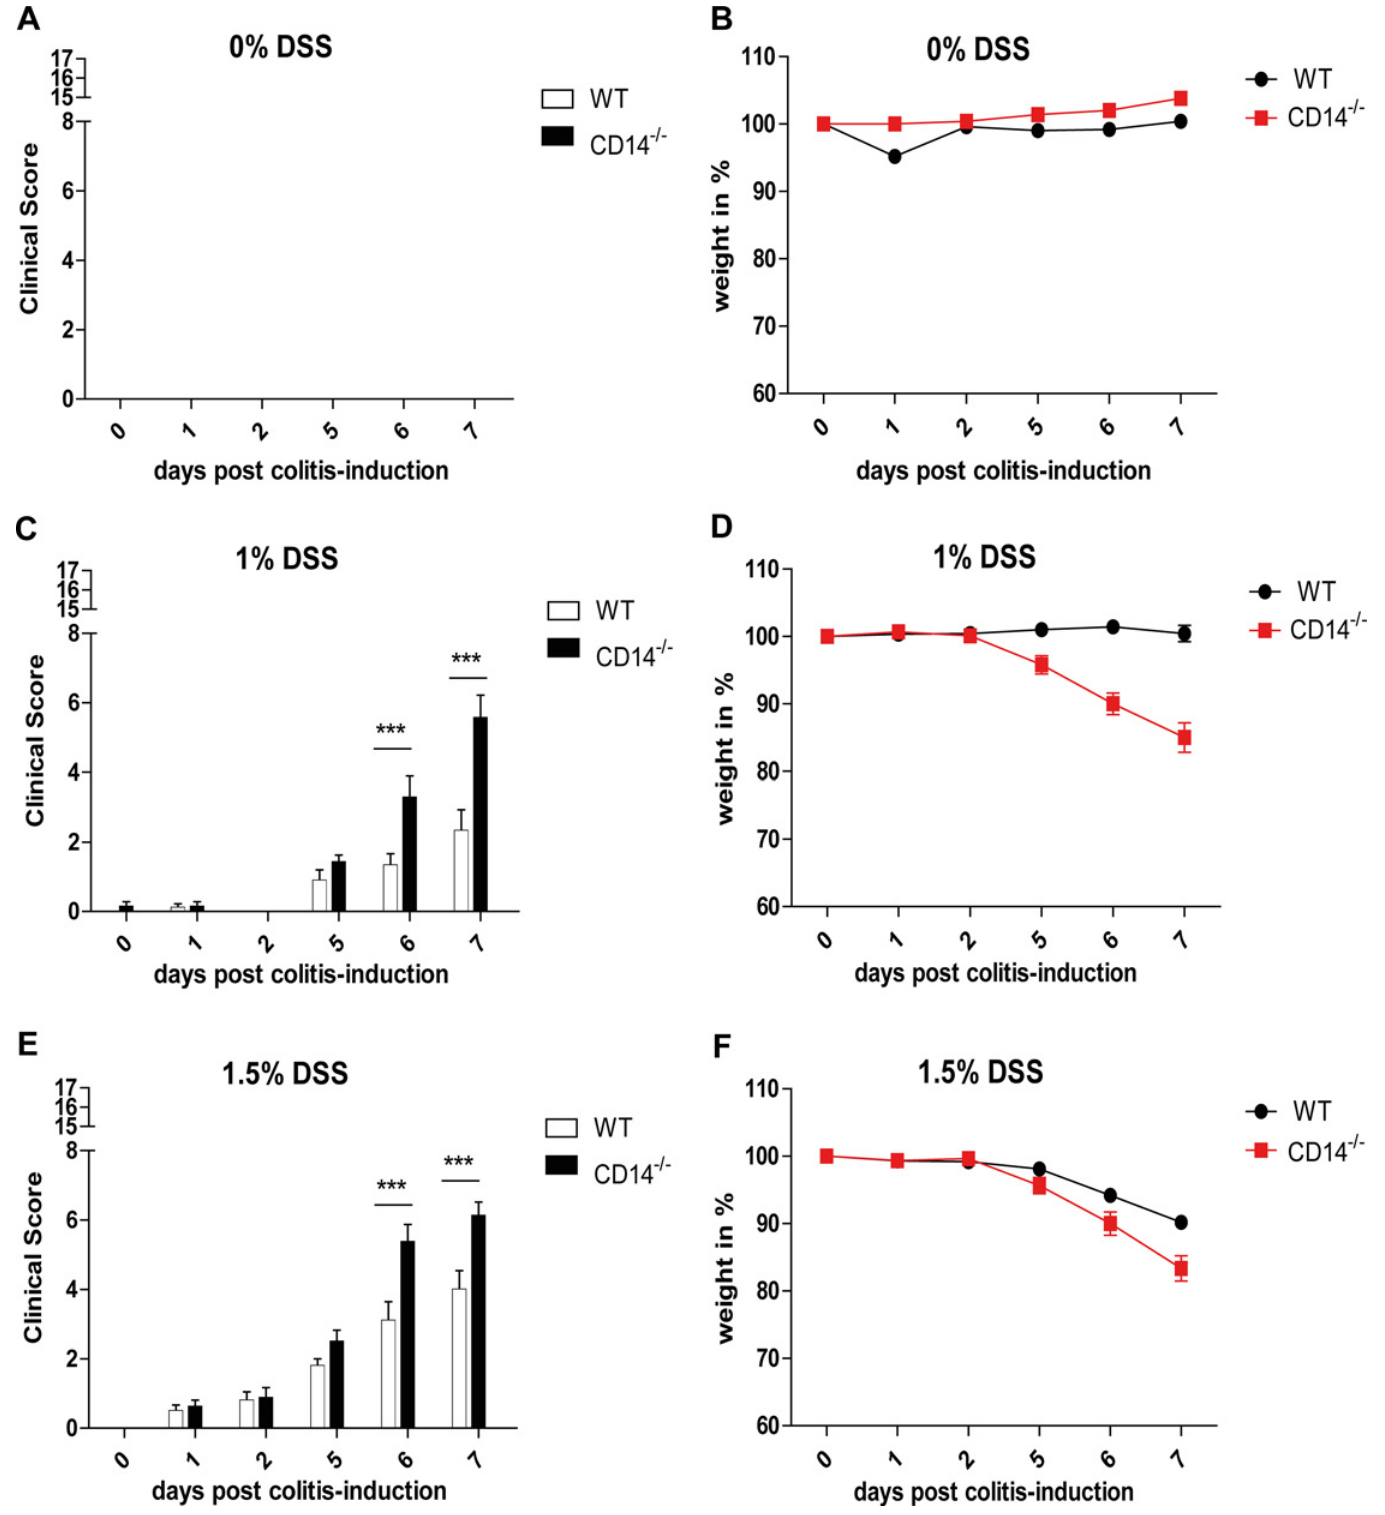
Fig 2. Clinical disease activity score after DSS treatment. Assessment of severity in controls (A, B) and DSS treated mice (1% DSS C, D and 1.5% DSS E, F) determined by an overall clinical disease activity score (A, C, E) and specifically by the change in body weight (B, D, F). Untreated controls exhibited low clinical scores (A) and a steady body weight (B). Mice treated with 1% (C, D) or 1.5% DSS (E, F) demonstrated increasing clinical scores and loss of body weight. Cd14 -/- mice showed significantly higher clinical scores and a significantly higher reduction of body weight than WT mice.